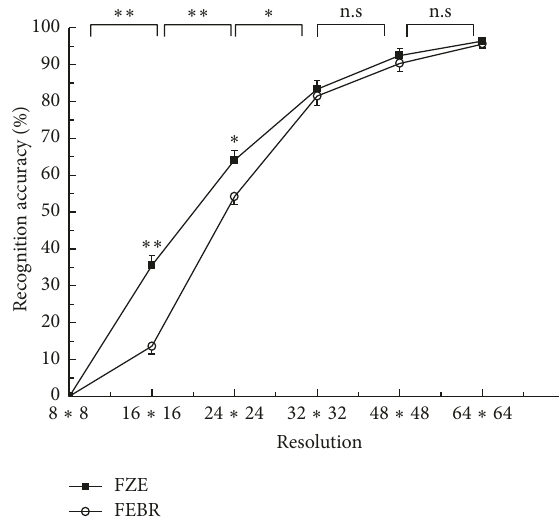
Figure 9: Comparison of the object recognition rate under different resolutions ( ∗ 𝑃 < 0.05 , ∗∗ 𝑃 < 0.01